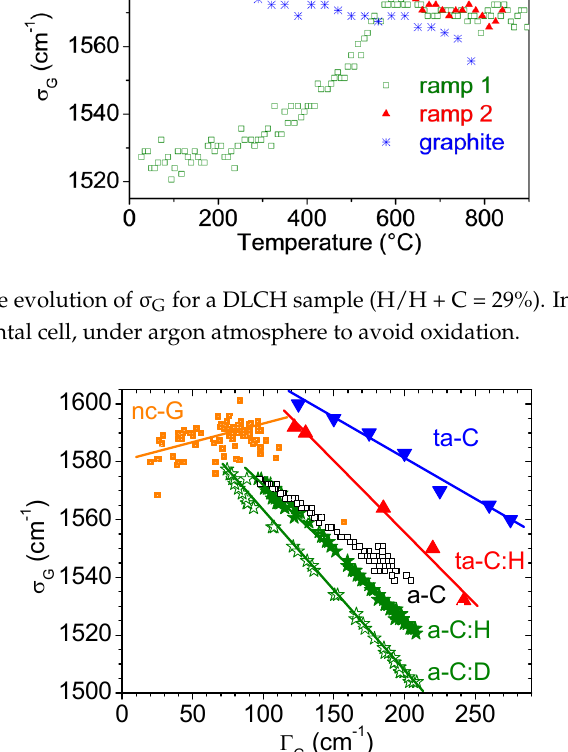
Figure 24. Plots of σ G vs. Г G for nc ‐ G and different amorphous carbons. Data were recorded with λ L = 514 nm. λ L = 514